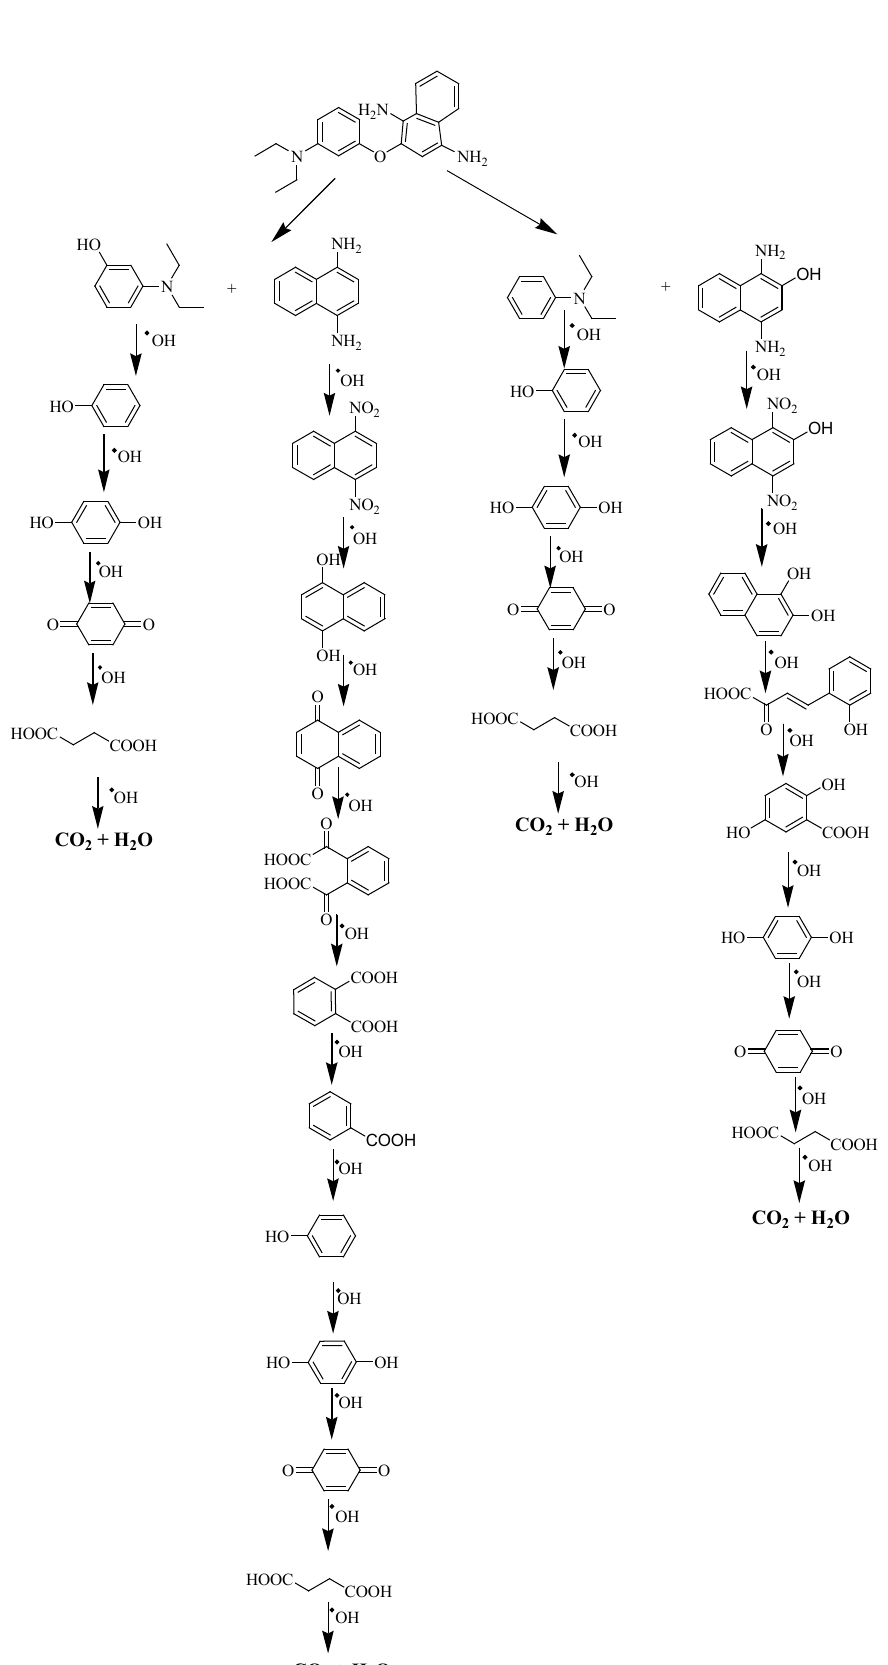
Scheme 1. Proposed mechanism for the degradation of NBS.